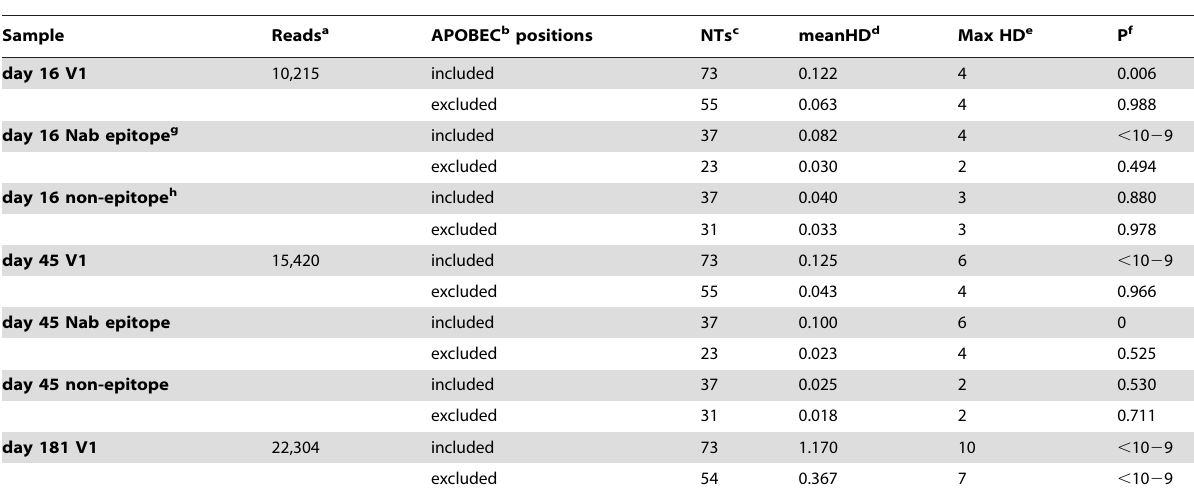
Table 4. Comparison with Poisson model of random sequence evolution.